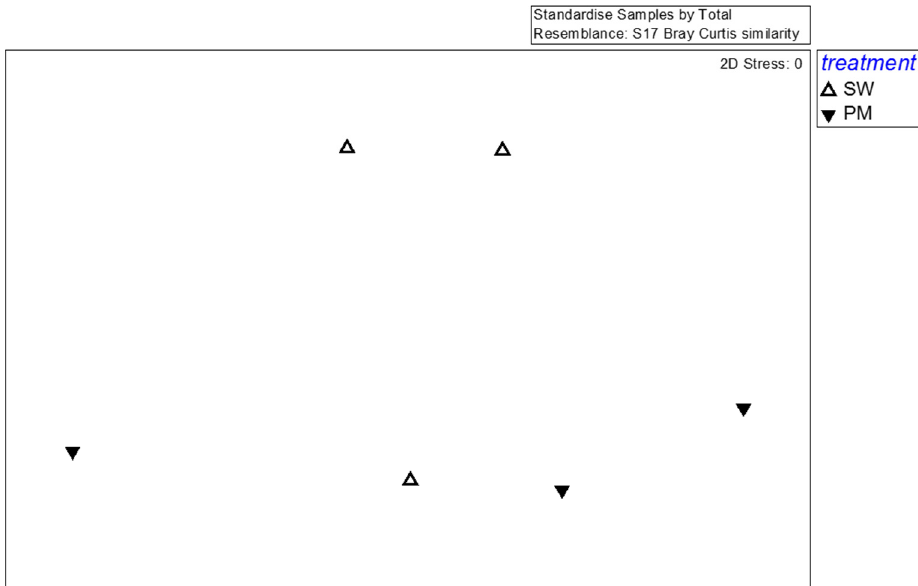
Figure 4. Multidimensional scaling of the fungal community at the species level from six compost samples. Fungal taxa with relative abundance >0.1% in at least one sample were considered. Symbols indicate different treatments: triangle, spent mushroom substrate with soy wastes; inverted triangle, spent mushroom substrate with swine and poultry manure.